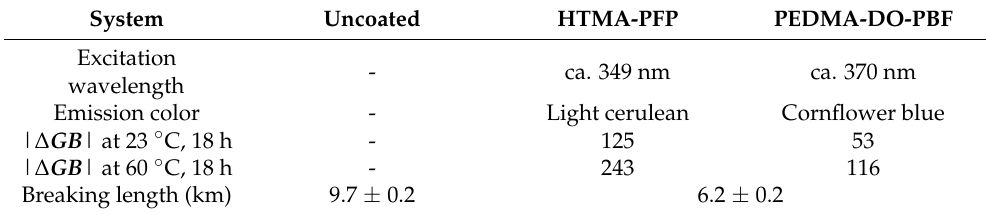
Table 2. Color properties and strength of the fluorescent paper-based probes, highlighting the loss of green and blue emissions by exposure to